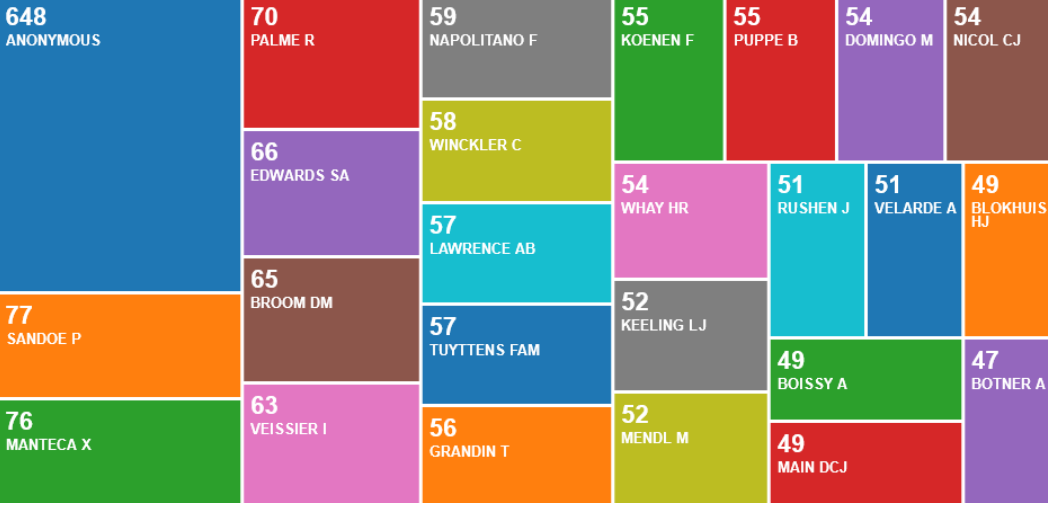
Figure 9. Number of publications per author, according to an online survey of animal welfare publications not by animal welfare centres in the Web of Science, May 2020